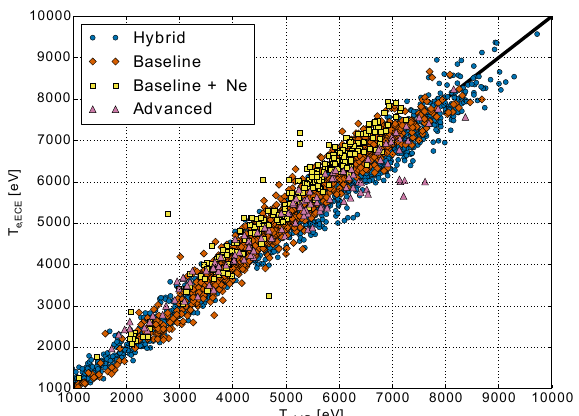
Figure 6: Comparison of peak temperatures for second and third harmonics X-mode in DD pulses.